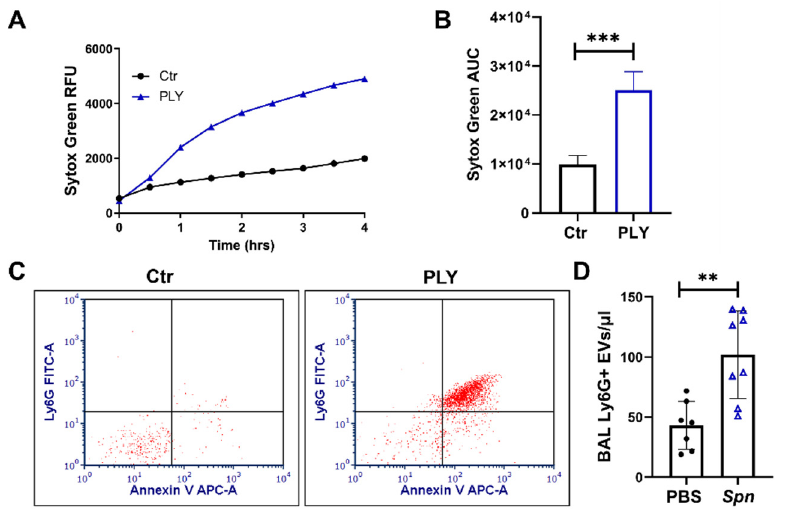
Figure 4. Neutrophil extracellular trap and EV production in murine neutrophils. ( A , B ) NET formation was quantified using the cell-impermeant nucleic acid dye Sytox Green in murine neutrophils treated with PLY (100 ng/mL) or HBSS (Ctr). ( A ) NET production (Sytox Green fluorescence) was monitored over a period of 4 h (representative graph). ( B ) Bars represent the area under the curve (AUC) for Ctr and PLY-treated neutrophils calculated from the kinetic curves. n = 9, *** p < 0.001, paired t -test. ( C ) Representative dot blots of nEVs isolated from murine neutrophils treated with vehicle (Ctr) or PLY (100 ng/mL) and stained with annexin V-APC and Ly6G-FITC. Double-positive EVs are within the upper right quadrant. n = 3. ( D ) Quantification of nEVs (Ly6G+) in the BAL of mice 48 h after S. pneumoniae ( Spn ) infection. n = 7–8 mice/group. ** p < 0.01, t -test.